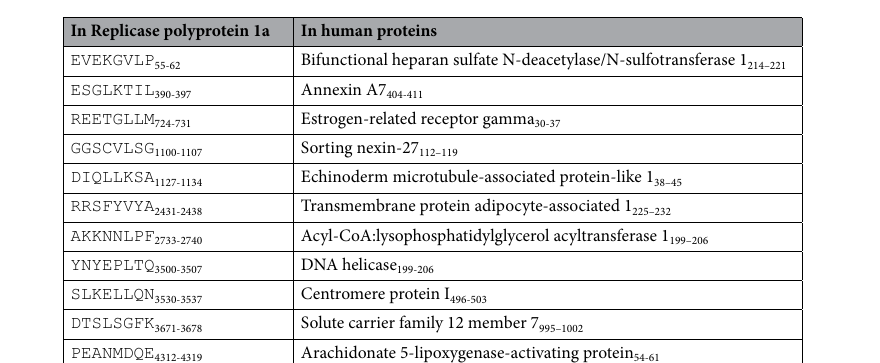
Table 11. Localization of homologous 8-mers in RPP 1a and human proteins.